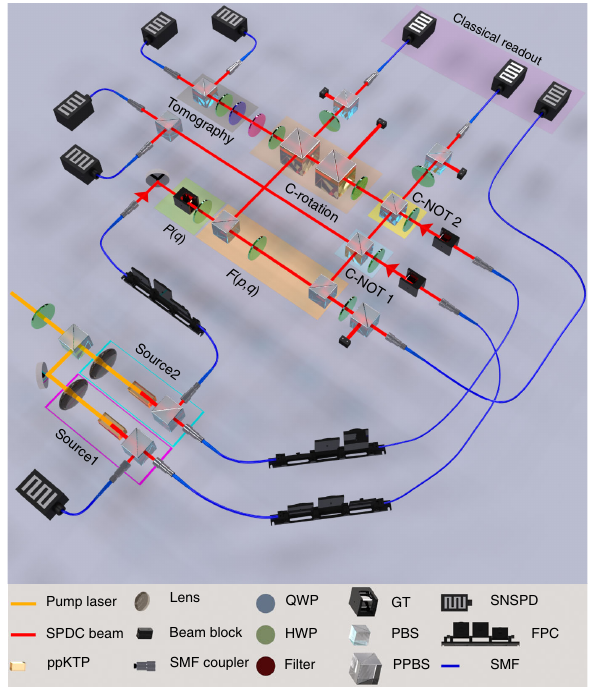
FIG. 3. Experimental setup. Single photons are generated from SPDC events. The herald photon from Source 1 is sent straight to a heralding detector. The polarization of the memory system is used to encode the relevant causal state in a qubit, using a half- wave plate (HWP). Ancillas are prepared in a fixed polarization using HWPs. To implement the fanning out from the memory qubit to a qutrit, a HWP and polarizing beam splitters (PBSs) are used. Each of the C-NOT 1 and C-NOT 2 gates is implemented using a HWP and a PBS. The C-rotation gate is realized via HWPs and partially polarizing beam splitters (PPBSs). In order to vary the relative delay between the single-photon wave packets, an automated translation stage is used to move one of the couplers. Classical readout is performed via projective measure- ments on the path modes of the qutrit, which collapses the memory state to the appropriate causal state. To verify the memory qubit, its state is reconstructed via quantum state tomography. A telecom bandpass filter is used in the tomography arm in order to spectrally filter the SPDC photons and maximize the visibility of the quantum interference. P stands for state preparation, SMF for single-mode fiber, QWP for quarter-wave plate, GT for Glan-Taylor prism, and FPC for fiber polarization controller. For more details, see Appendix